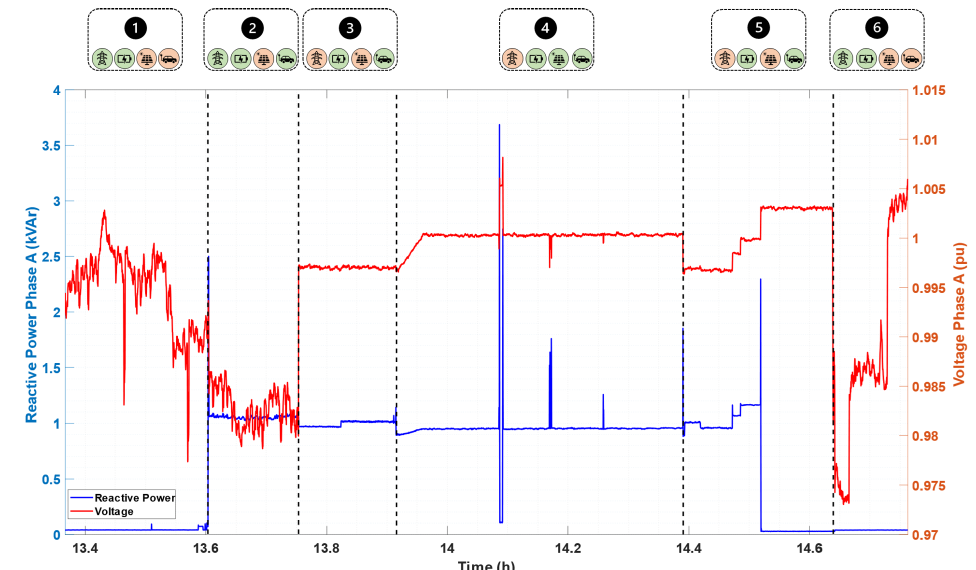
Figure 9. Reactive power and system voltage collected by power